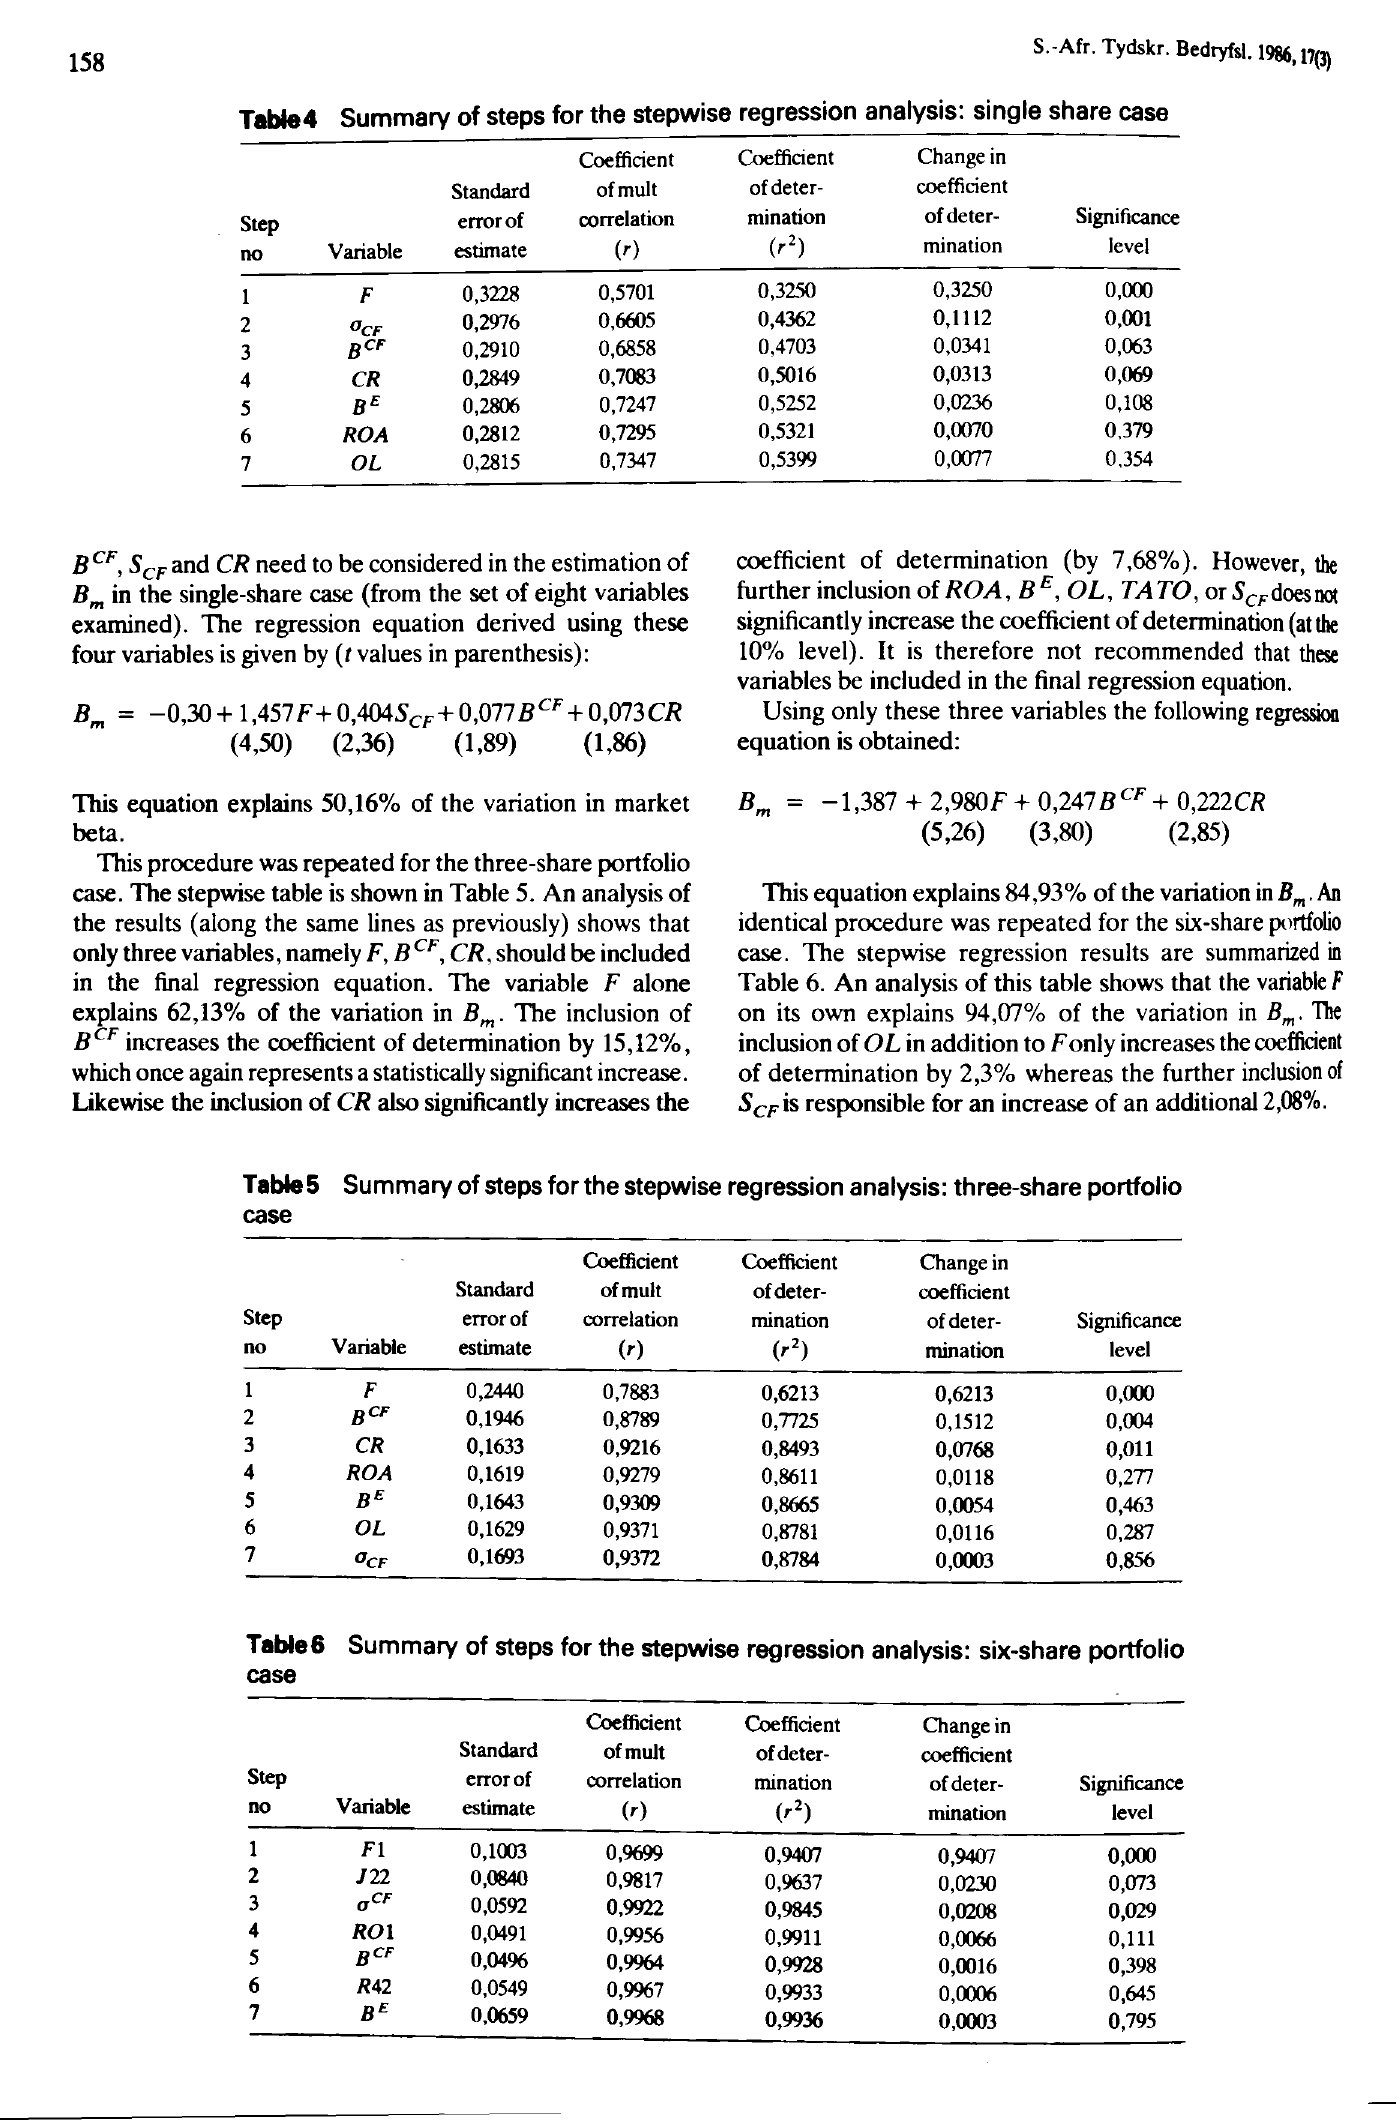
Table& Summary of steps for the stepwise regression analysis: six-share